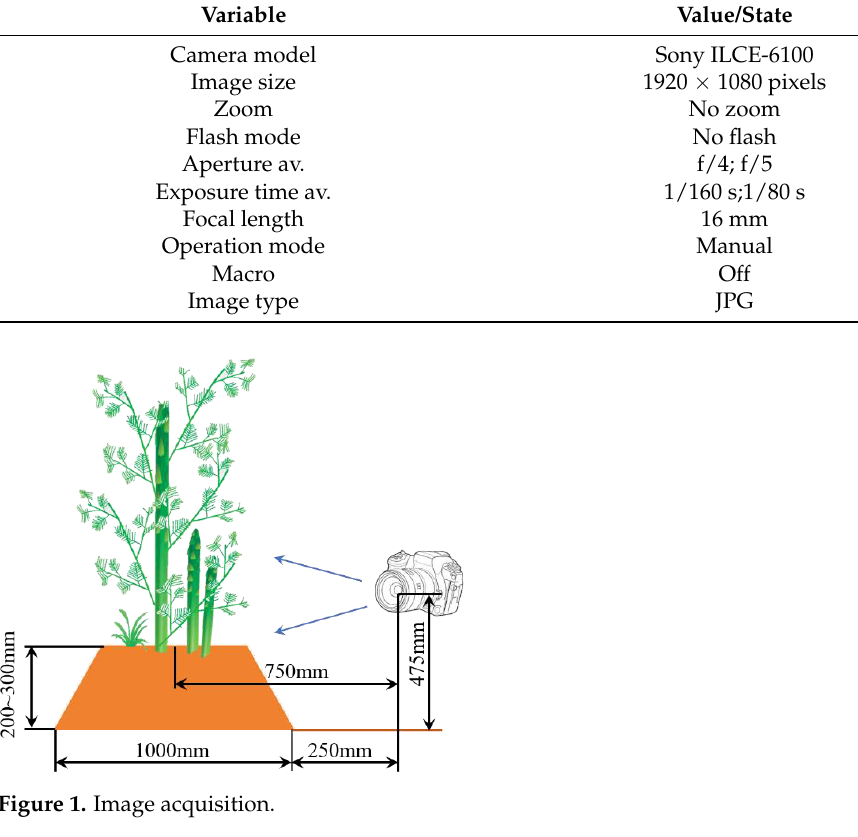
( b ) Figure 2. Photos of asparagus under different lighting conditions. ( a ) Image acquired on a cloudy day; ( b ) image acquired on a sunny day. 2.2. Data Labeling LabelImg software was used for the labeling process, and the labeled files were all in XML format. When applied to the YOLO algorithm, the labeled files only need to perform format conversion. Given that the machine only harvests the current row during the har- vesting process, it only labeled the asparagus where the current row was located and con- sidered the asparagus in the distance as the background. The labeled images are shown in Figure 3.